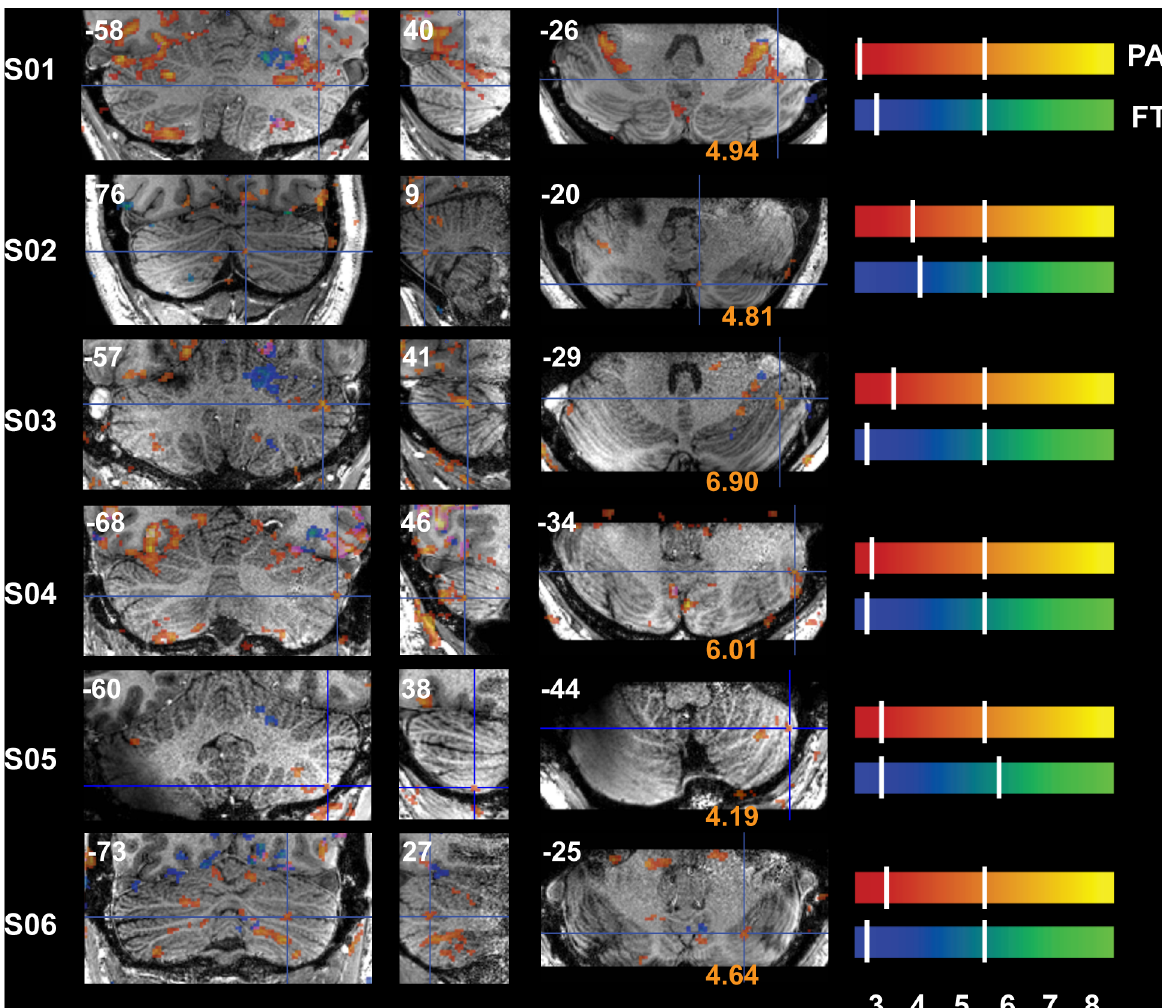
Fig 5. Functional Delineation of Task-Related Activity, Pro-Anti Activations in CrusI and CrusII. PA-related activity is also seen in h CrusI and/or h CrusII (crosshairs); presumably due to the cognitive component required to plan and execute a volitional anti-saccades. Clusters occur in either dorsal CrusI (S01, S03 and S06) or medioventral CrusII (S02, S04 and S05). Slice locations (in non-normalized MNI space) are displayed at the top of each panel and T- values at the crosshairs are displayed at the bottom of the axial (rightmost) panels. Refer to Fig 1a for a guide to anatomical lobule definitions.